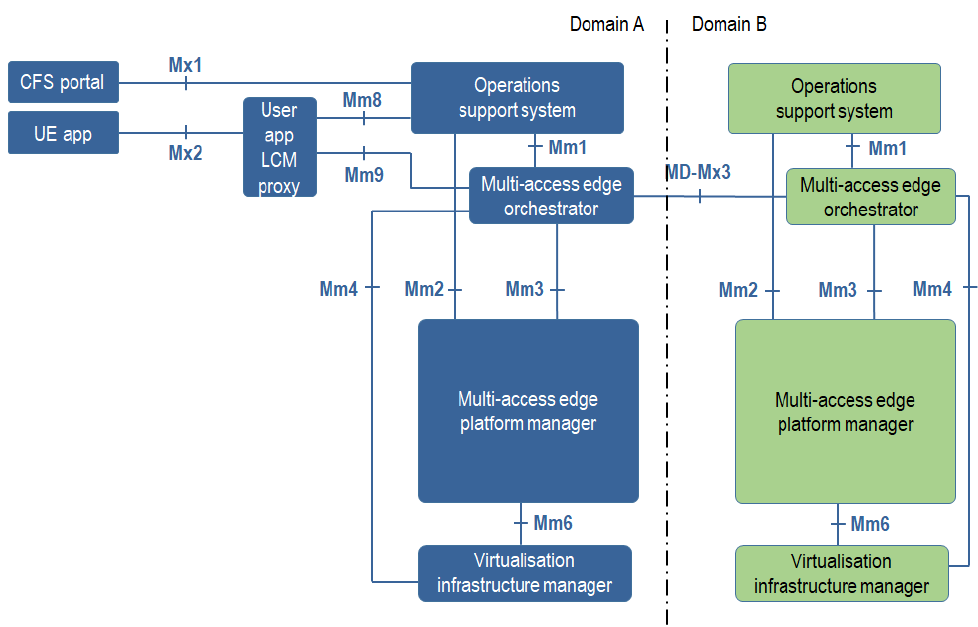
Figure 6. Interconnection of MEC systems from different providers.